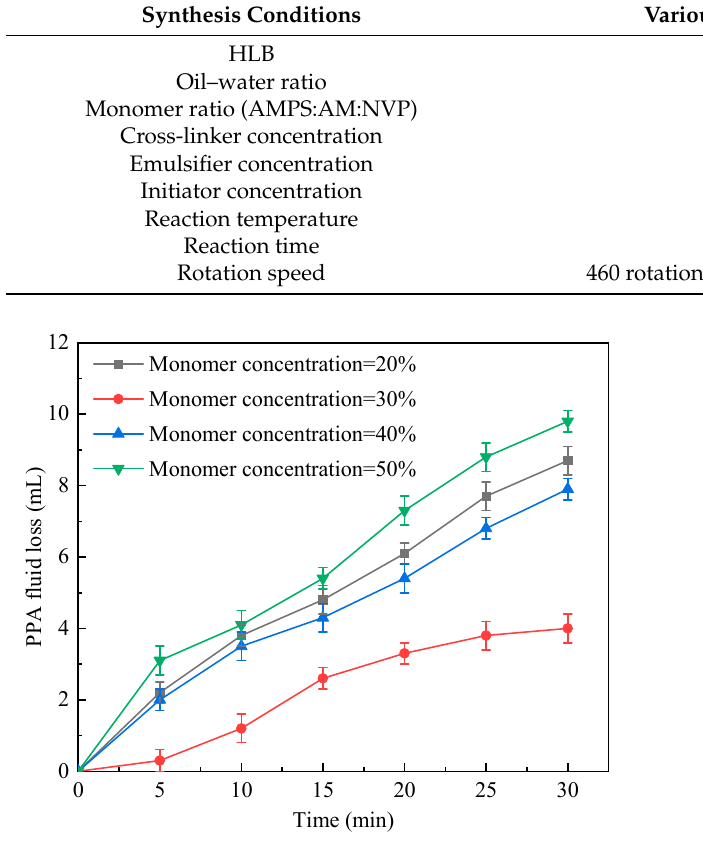
Figure 4. PPA fluid loss vs. time in cases of different total monomer concentrations.